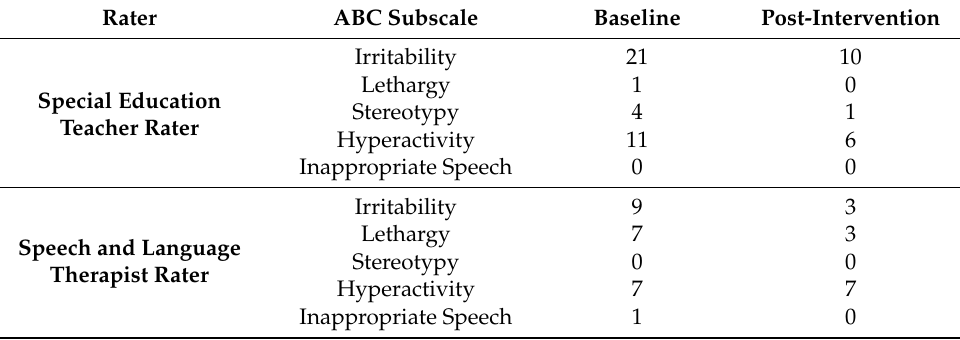
Figure 3. Results of the feasibility stage. Improvement in symptoms of irritability, hyperactivity, and social withdrawal as determined by percentage reduction in ABC subscale scores post-intervention relative to baseline. Irritability was improved by 59.5%, hyperactivity by 37.6%, and social withdrawal by 80.1%. Table 2. Feasibility stage ABC subscale scores for Participant 1.